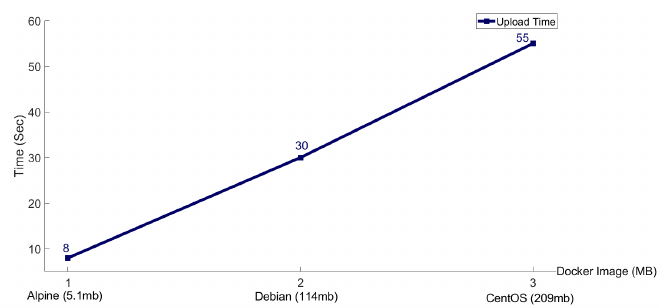
Figure 5. Comparison of upload time with Alpine, Debian and CentOS.